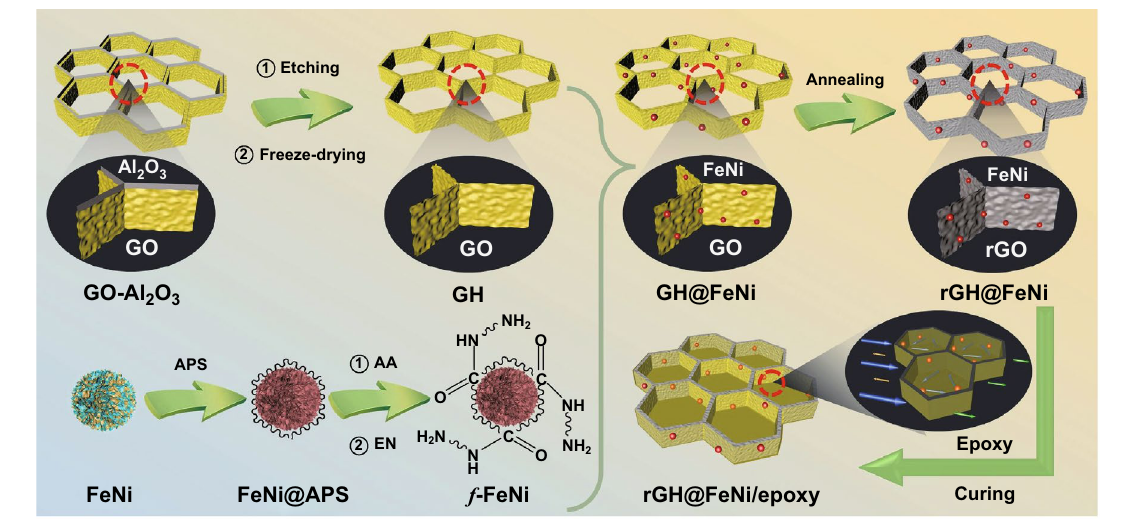
Fig. 1 Schematic diagram of the fabrication for rGH@FeNi/epoxy composites